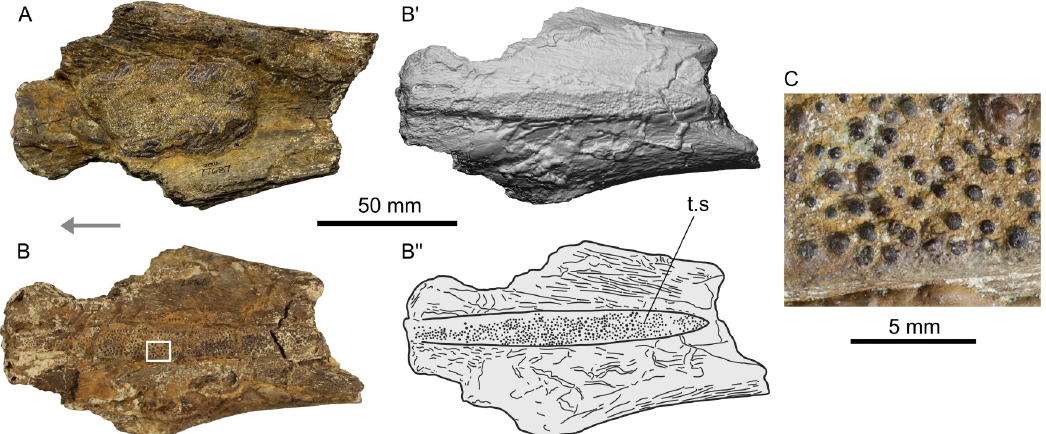
Fig 4. Photographs, surface rendering (apostrophe) and schematic drawing (double apostrophes) of anterior portion of parasphenoid (SMU 77687) of Mawsonia sp. from the Woodbine Formation, in dorsal (A) and ventral (B) views. The area indicated in B (white rectangle) is detailed in the microphotograph of C. Abbreviations: t.s, toothed surface. The arrow indicates the anterior